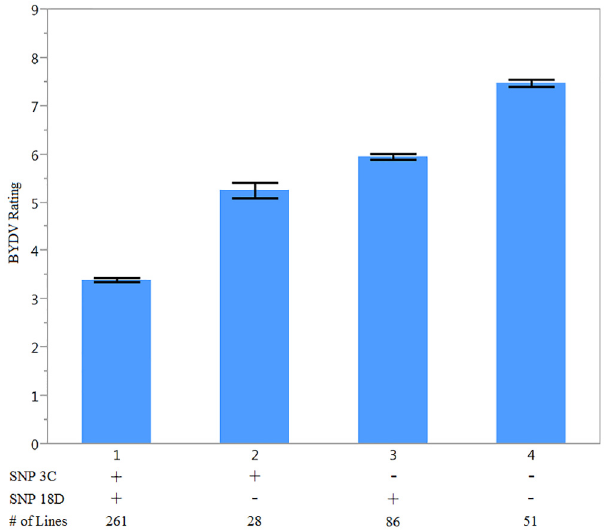
Fig 2. Phenotypic mean values for BYDV tolerance for oat haplotypes containing different SNP allele combinations with error bars representing one standard error. “ + ” signifies a favorable allele. BYDV rating scale is from 0 to 9 where 0 = most tolerant and 9 = most sensitive.